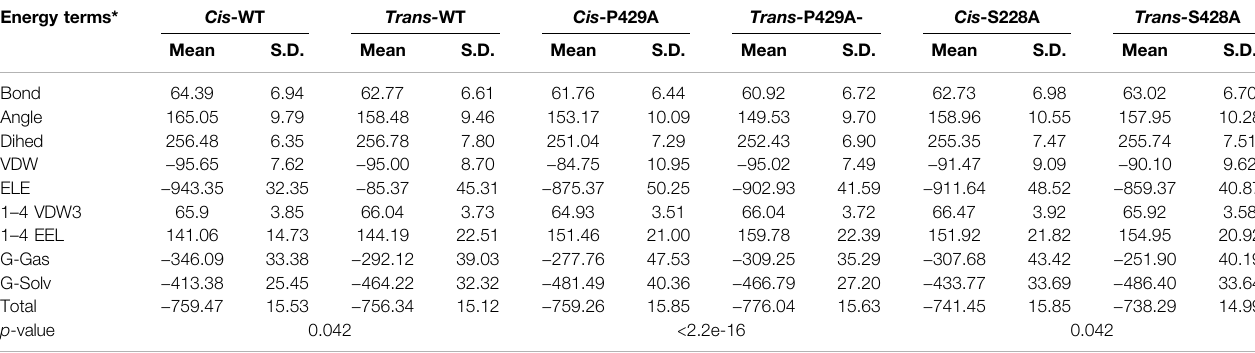
TABLE 3 | Calculated total free energies and components of wild-type and mutant ATR peptides (WT: NLSSNSDGIS428P429KRRRLSSSL; S428A: NLSSNSDGIA428P429KRRRLSSSL; and P429A: NLSSNSDGIS428A429KRRRLSSSL).* All values are reported in kcal/mol. p -values are from two-sided Student ’ s